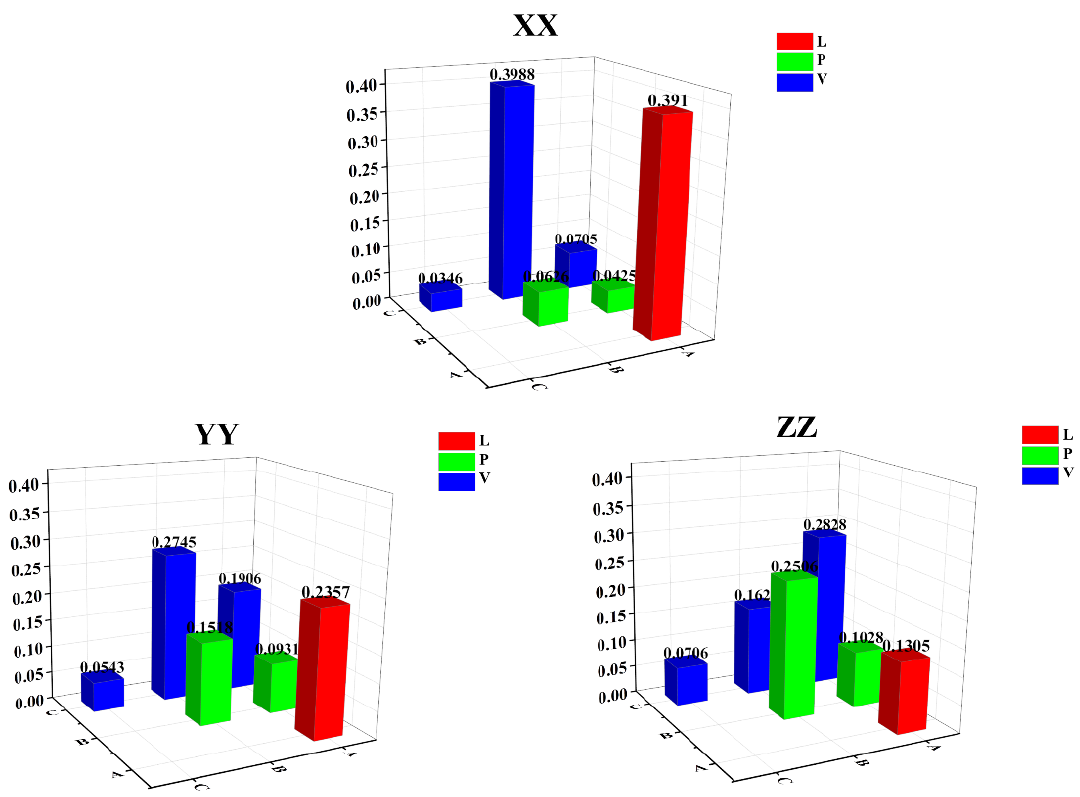
Figure 10. Results of the global sensitivity analysis.